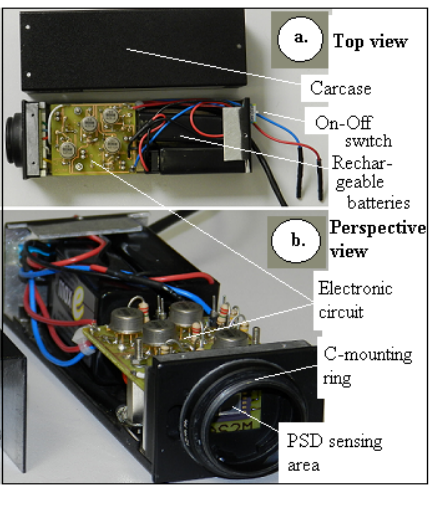
Figure 3. The custom-made PSD circuit featuring a C-mount standard ring and an embedded electrical